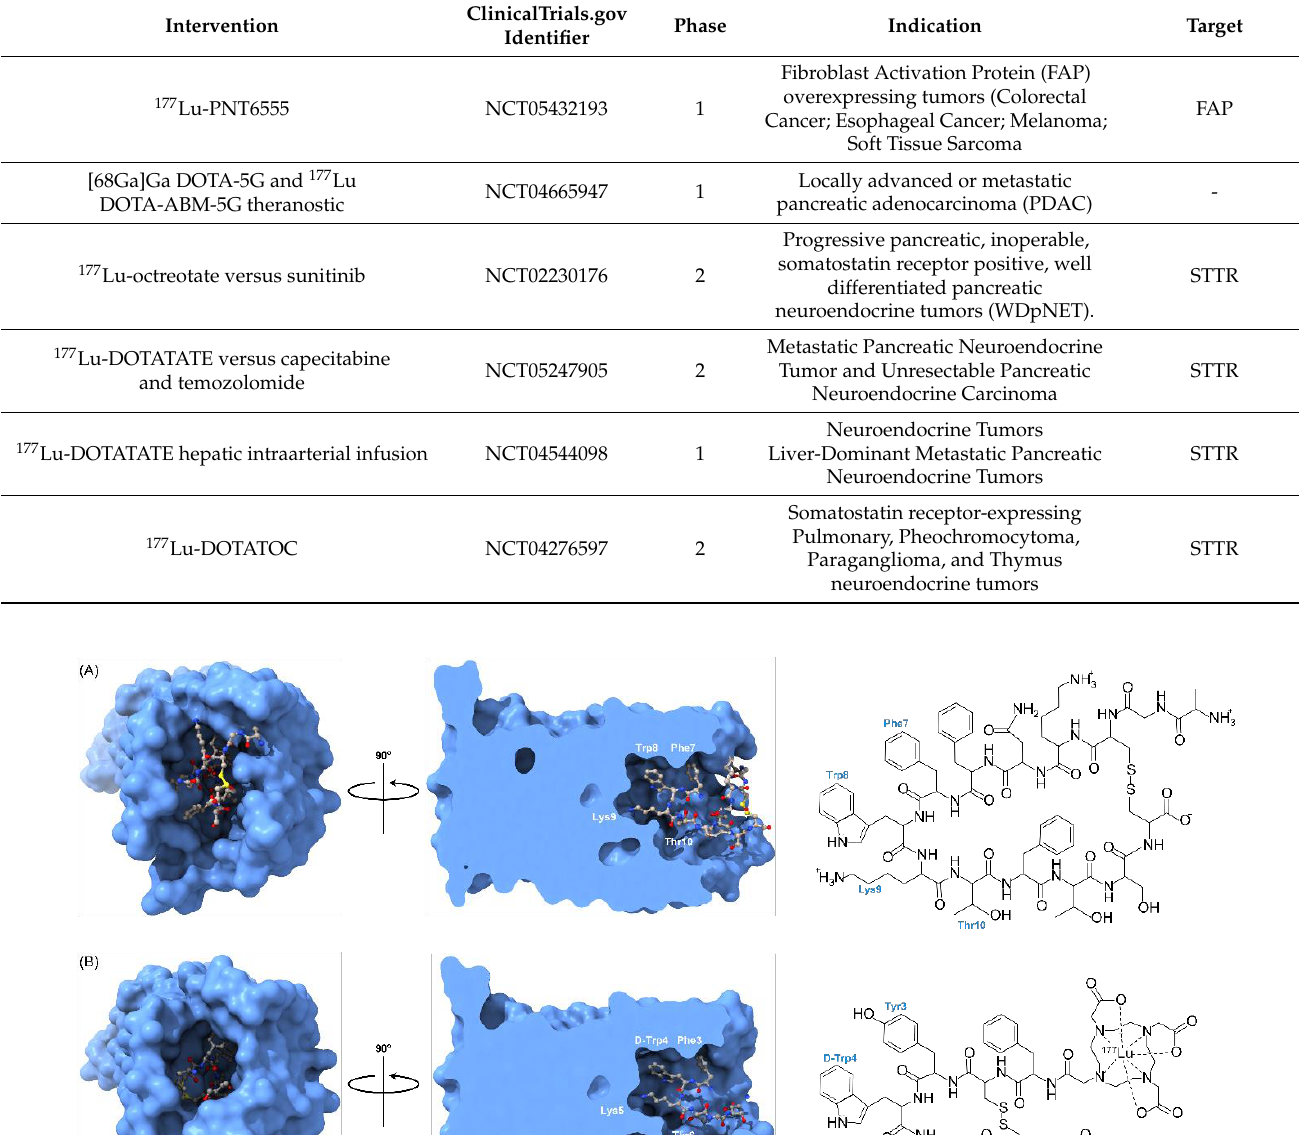
Table 3. Current clinical applications and trials of Lutetium-177 ( 177